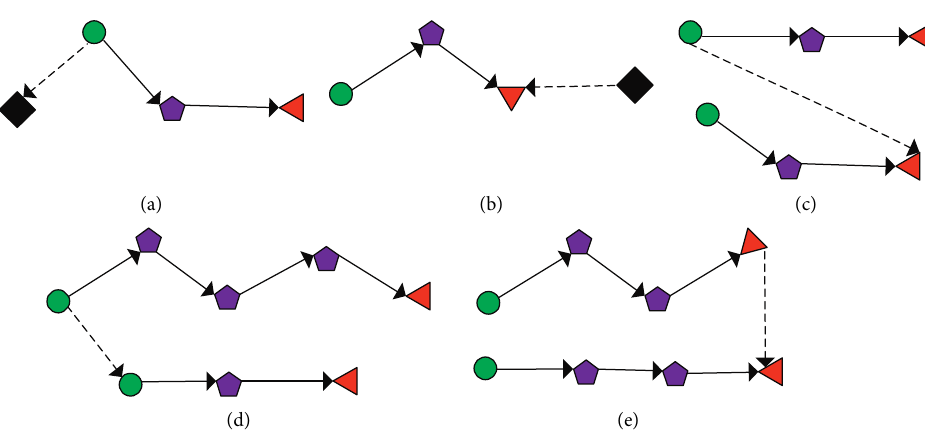
Figure 2: The type of candidate edges. (a) SI: edges from a start node to an isolated node; (b) IE: edges from an isolated node to an end node; (c) SE: edges from a start node to an end node; (d) SS: edges from a start node to a start node; (e) EE: edges from an end node to an end node. Candidate edges are marked by dashed edges; isolated nodes are marked by black diamonds; start nodes are marked by green circles; middle nodes are marked by violet pentagons; end nodes are marked by red triangles.